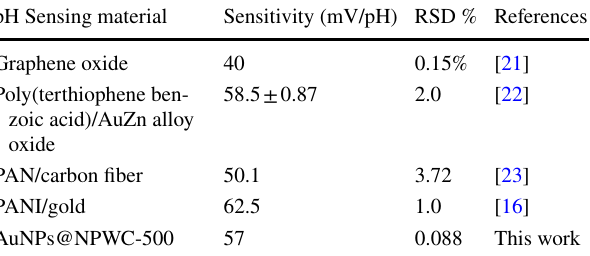
Table 1 Comparison of different electrochemical sensor proposed for the determination of pH pH Sensing